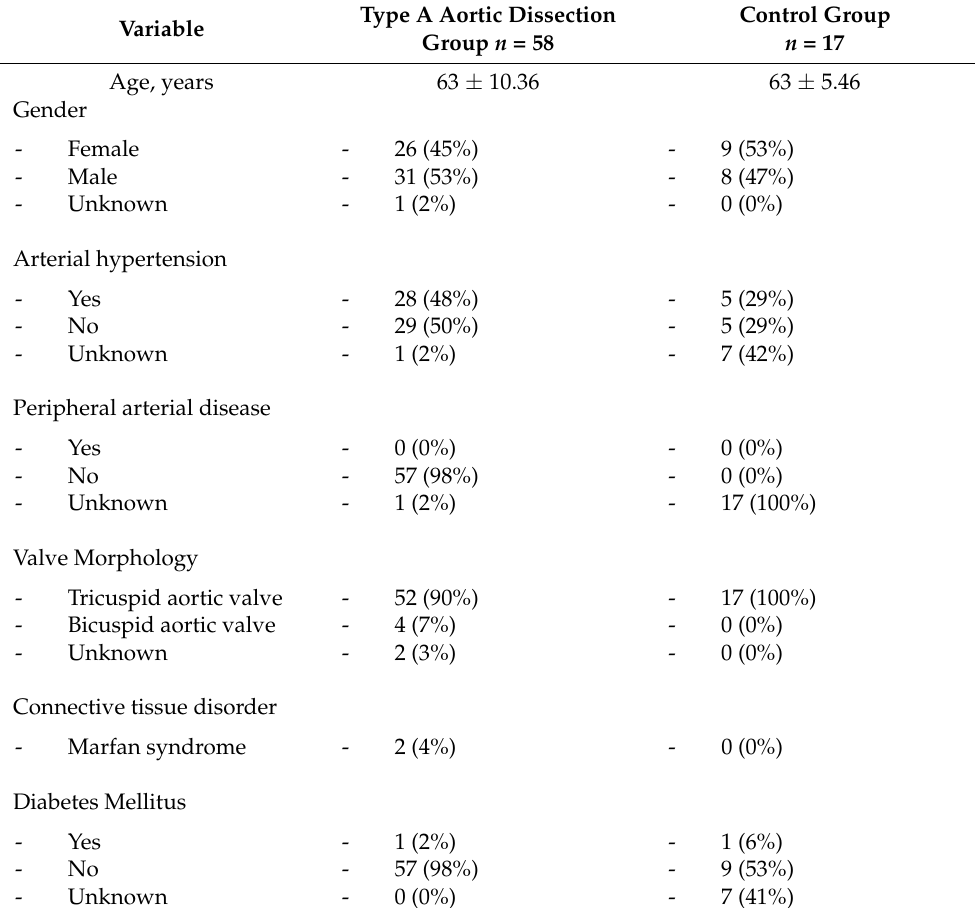
Table 2. Baseline